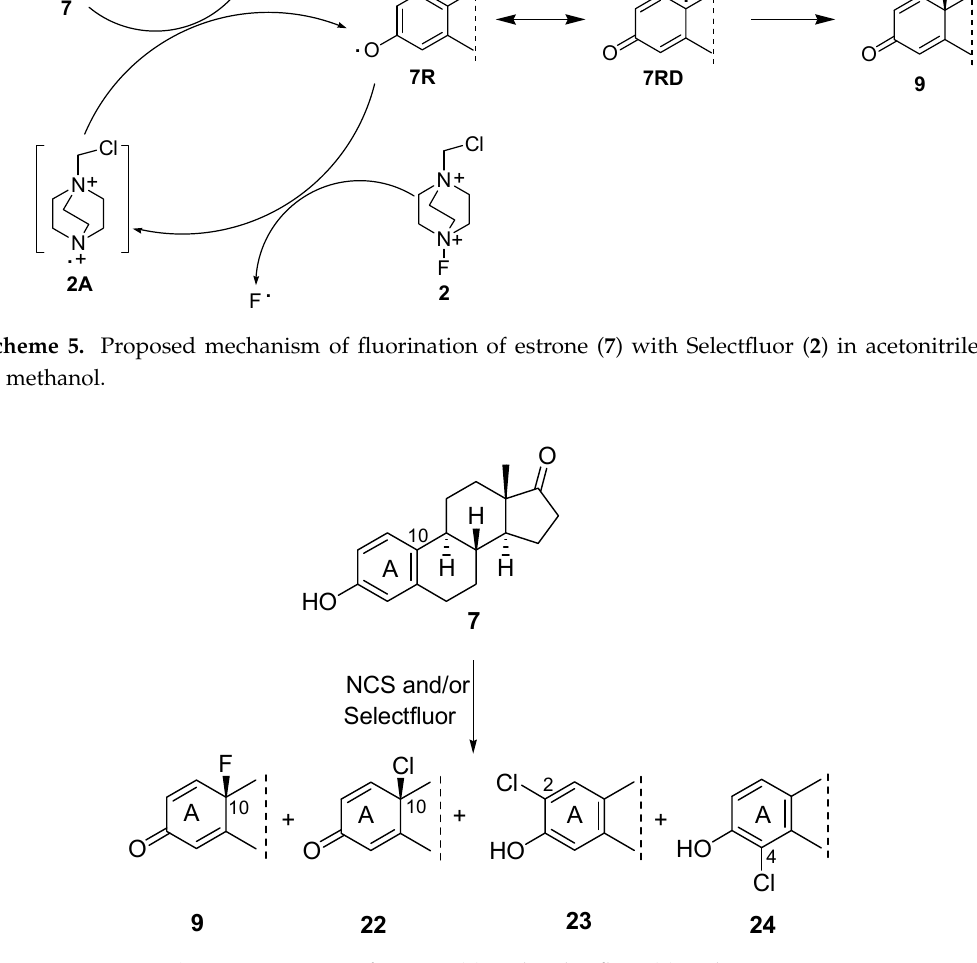
Table 2. Effect of the reaction conditions on the fluorination and/or chlorination of compound 7 Entry Substrate NCS and or Selectfluor (1.1